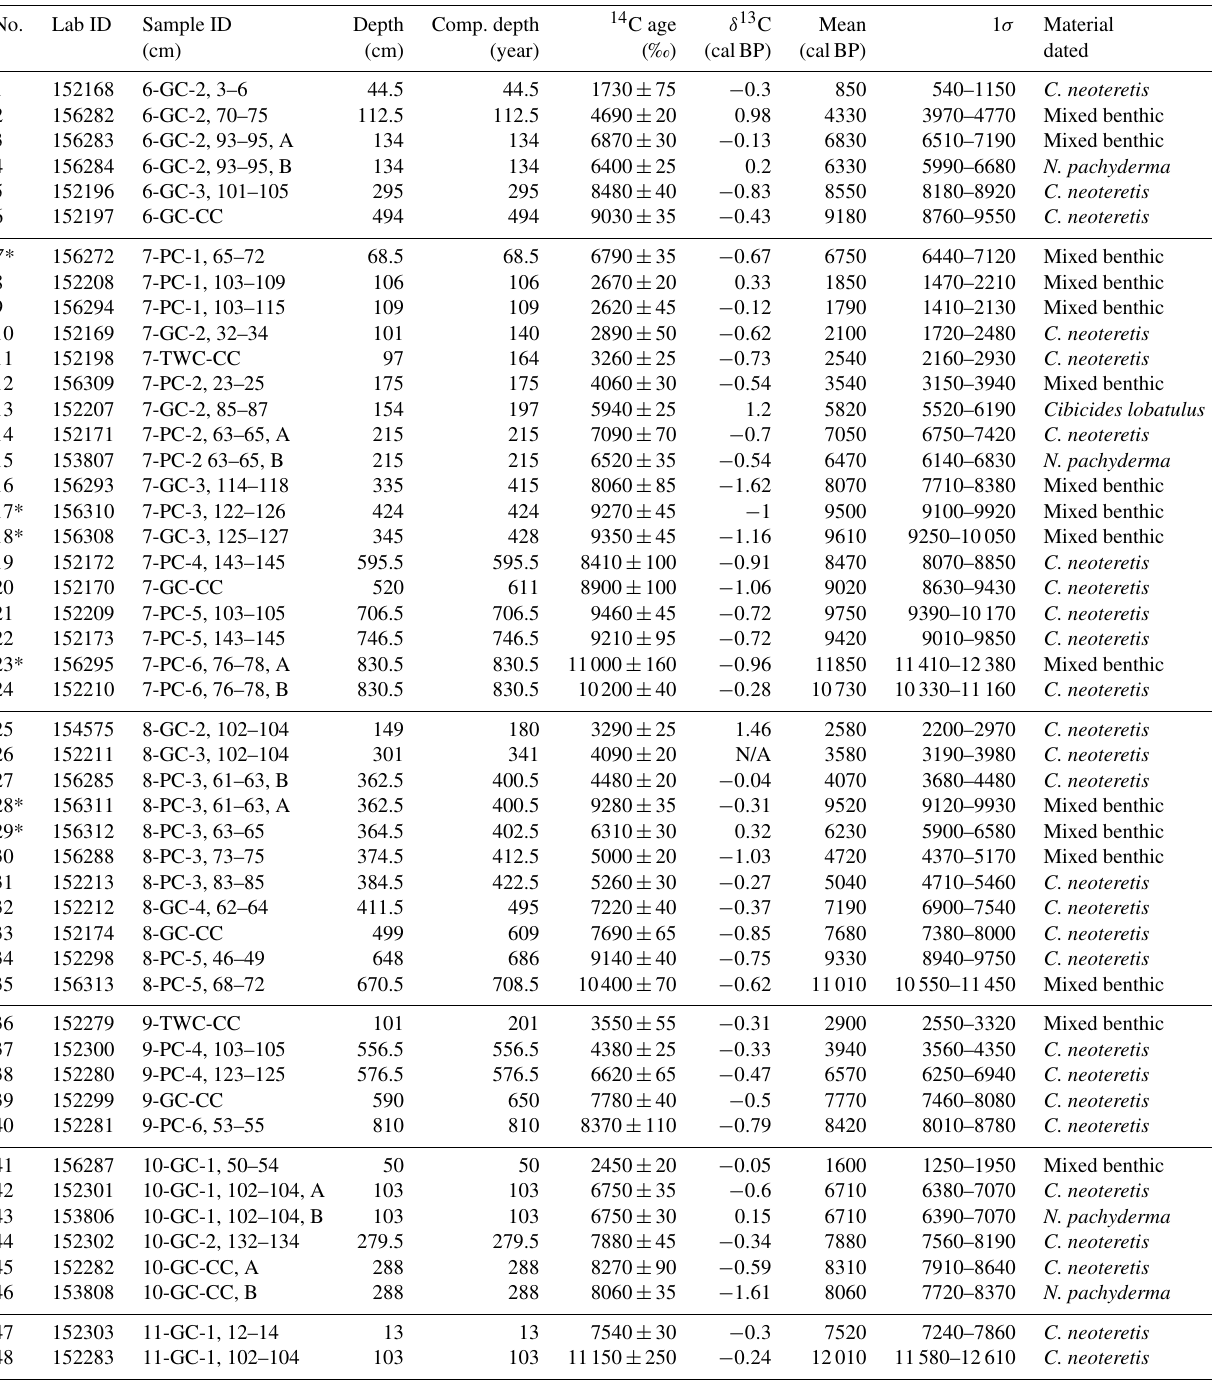
Table 3. Raw and calibrated radiocarbon dates and the type of material analyzed. All data were calibrated using a (cid:49)R 300 ± 300 years. Asterisks highlight ages deemed outliers. All the outliers came from samples with low microfossil abundance on which mixed benthic assemblages were